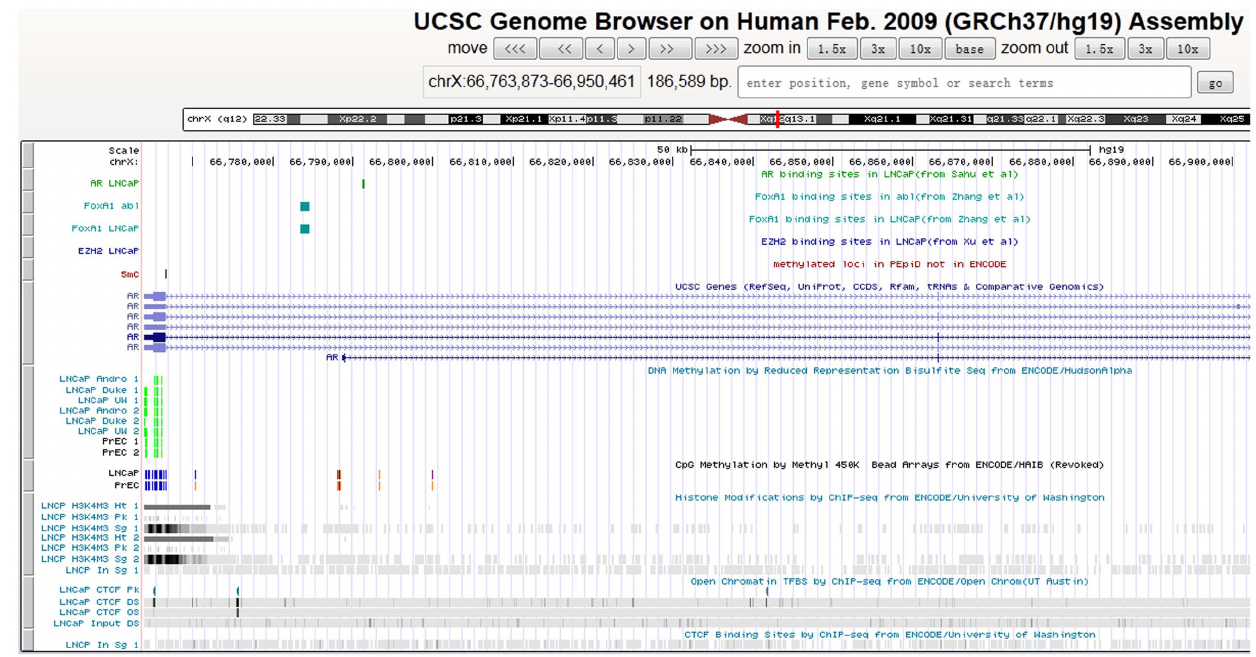
Figure 2. Track view of prostate specific epigenetic marks in gene AR. The top block in the track view shows our curated regulators AR, FoxA1, EZH2, and DNA methylation loci (not from ENCODE project). Then it follows UCSC gene track, DNA methylation, histone modifications, and CTCF binding sites from ENCODE project, respectively.